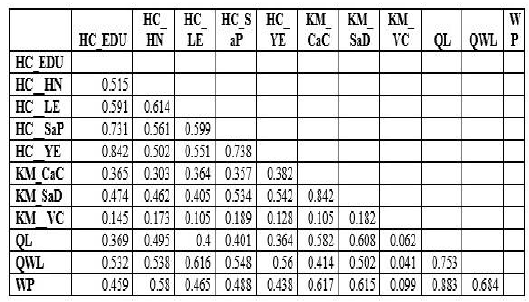
Table 7: Heterotrait-Monotrait (HTMT) Ratio